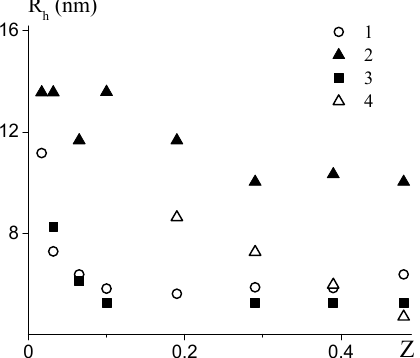
Figure 3. Hydrodynamic radius R h as a function of composition Z for the toluene sols of (1) monochelic M1 —CdSe QDs, (2) telechelic T2 —CdSe QDs, (3) telechelic T1 —CdSe/ZnS QDs, and (4) telechelic T2 —CdSe/ZnS QDs.